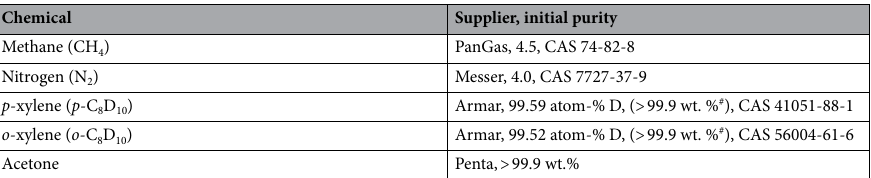
Table 1. Used gases and chemicals, initial purity as in the certificate of analysis by the supplier unless indicated otherwise. # Chemical purity was not declared by the supplier and was determined using a GC–MS (Clarus 500, Perkin Elmer) with a capillary column containing Elite WAX ETR stationary phase (Perkin Elmer), value represents purity with respect to other C 8 aromatic hydrocarbons.